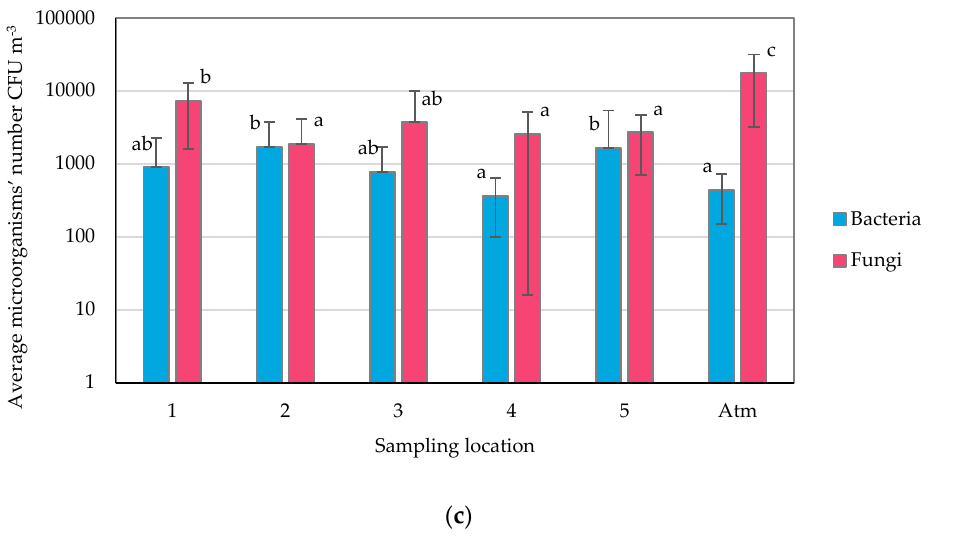
Figure 1. Averaged microorganism numbers (means with SD): ( a ) daily, ( b ) over sampling time of the day, ( c ) over sampling location; statistically different samples are marked with different letters; no le tt ers indicate no statistical di ff erences (Tukey’s test, α = 0.05).